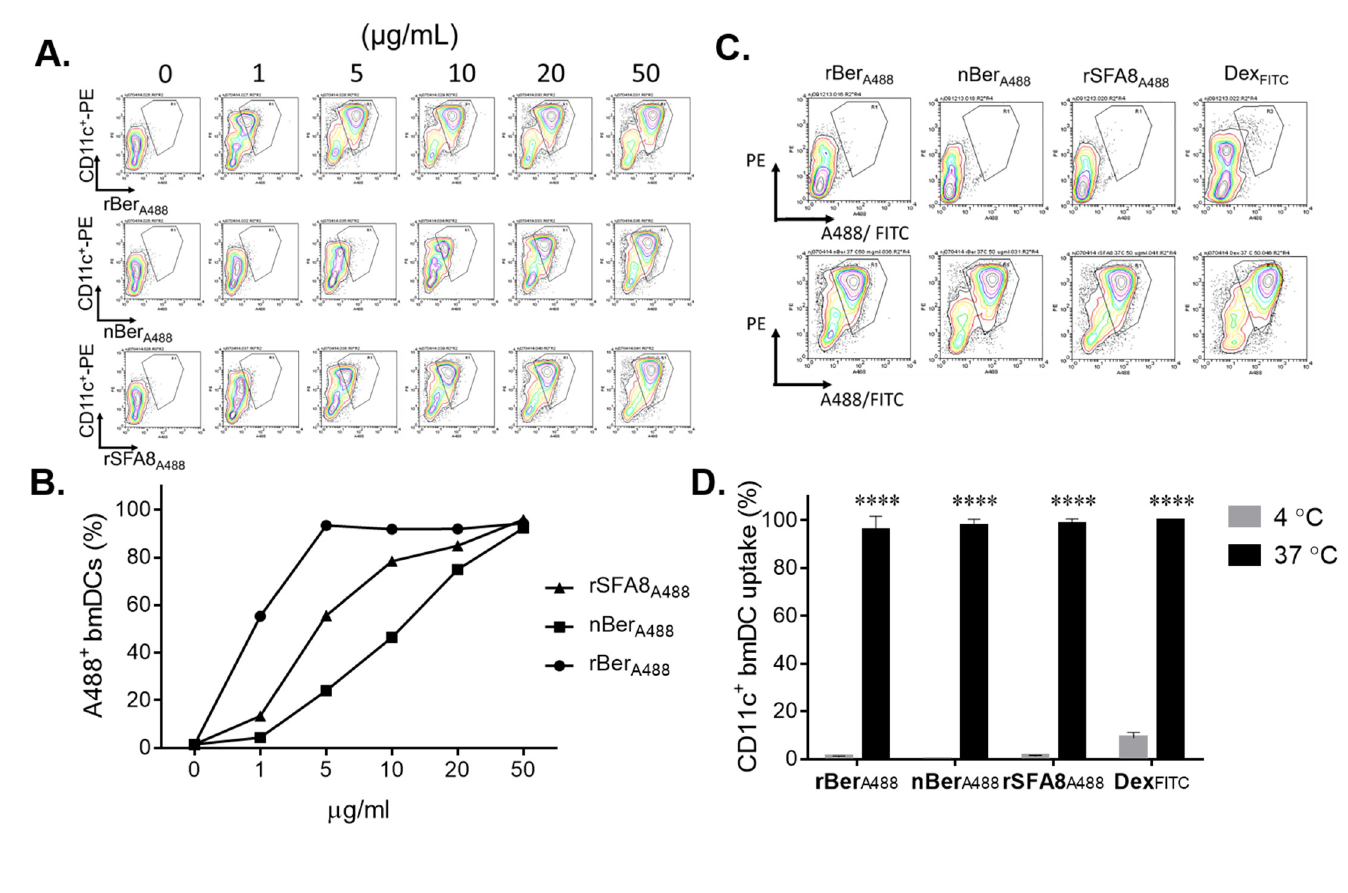
Fig 3. Uptake of glycosylated Ber e 1 and non-glycosylated Ber e 1 and SFA8 by bmDC. (A.) The contour plots represent cell populations where cells in the gating area are CD11c + bmDC with A488-labelled proteins. DC uptake was performed with increasing concentration (1–50 μ g/ml) of A488-labelled 2S albumin proteins for 45 min (B.). Data were normalised as a percentage of A488 + and PE + gated cells relative to the untreated control. (C.) The contour plot showed the distribution of CD11c + /A488 + or FITC + cell population in the gated region. Proteins were internalised as shown when bmDC were pulsed for 45 min with labelled proteins at 4˚C (cell-surface bound) and 37˚C (internalised). Data were normalised to a percentage of the A488/FITC + bmDC population incubated with Dextran-FITC at 37˚C and are presented as mean ± S. D. (n = 2) ���� p < 0.0001 (D.).